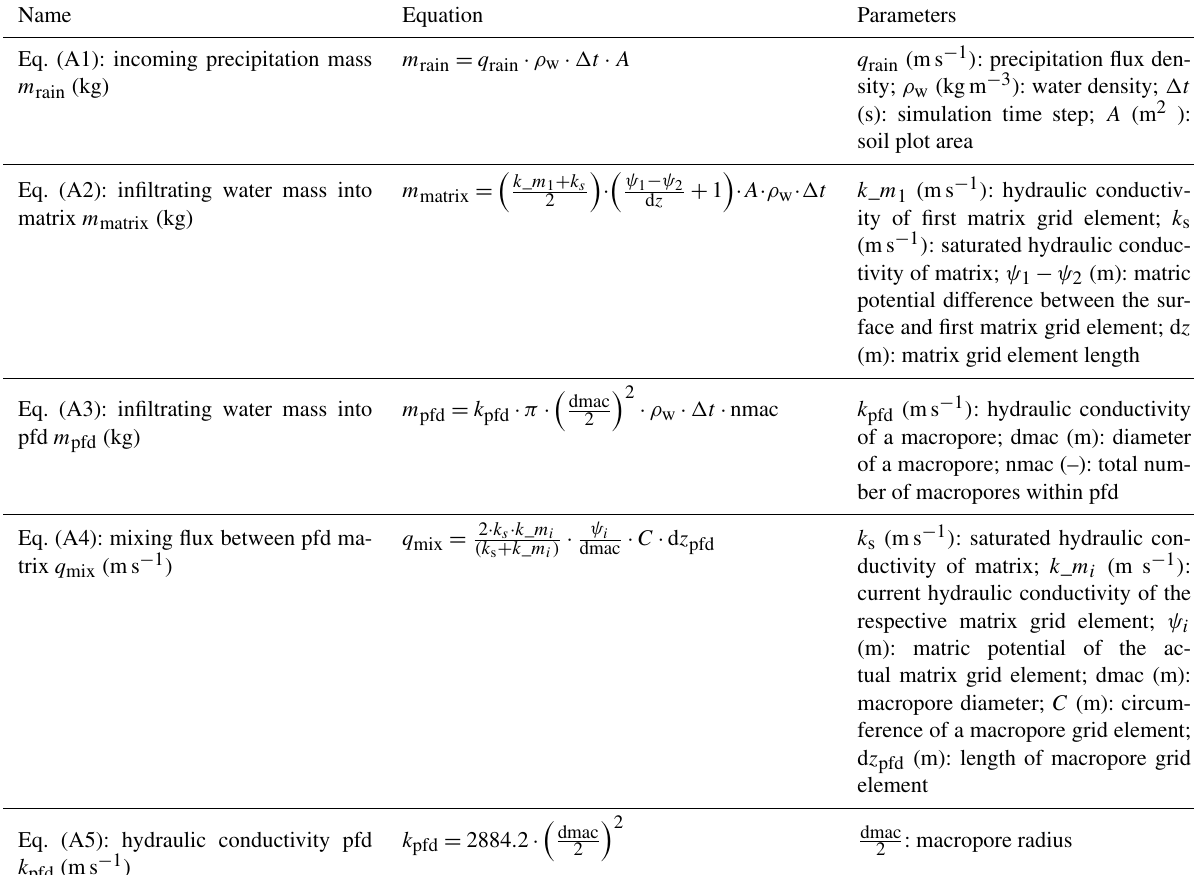
Table A1. Relevant LAST-Model equations and related